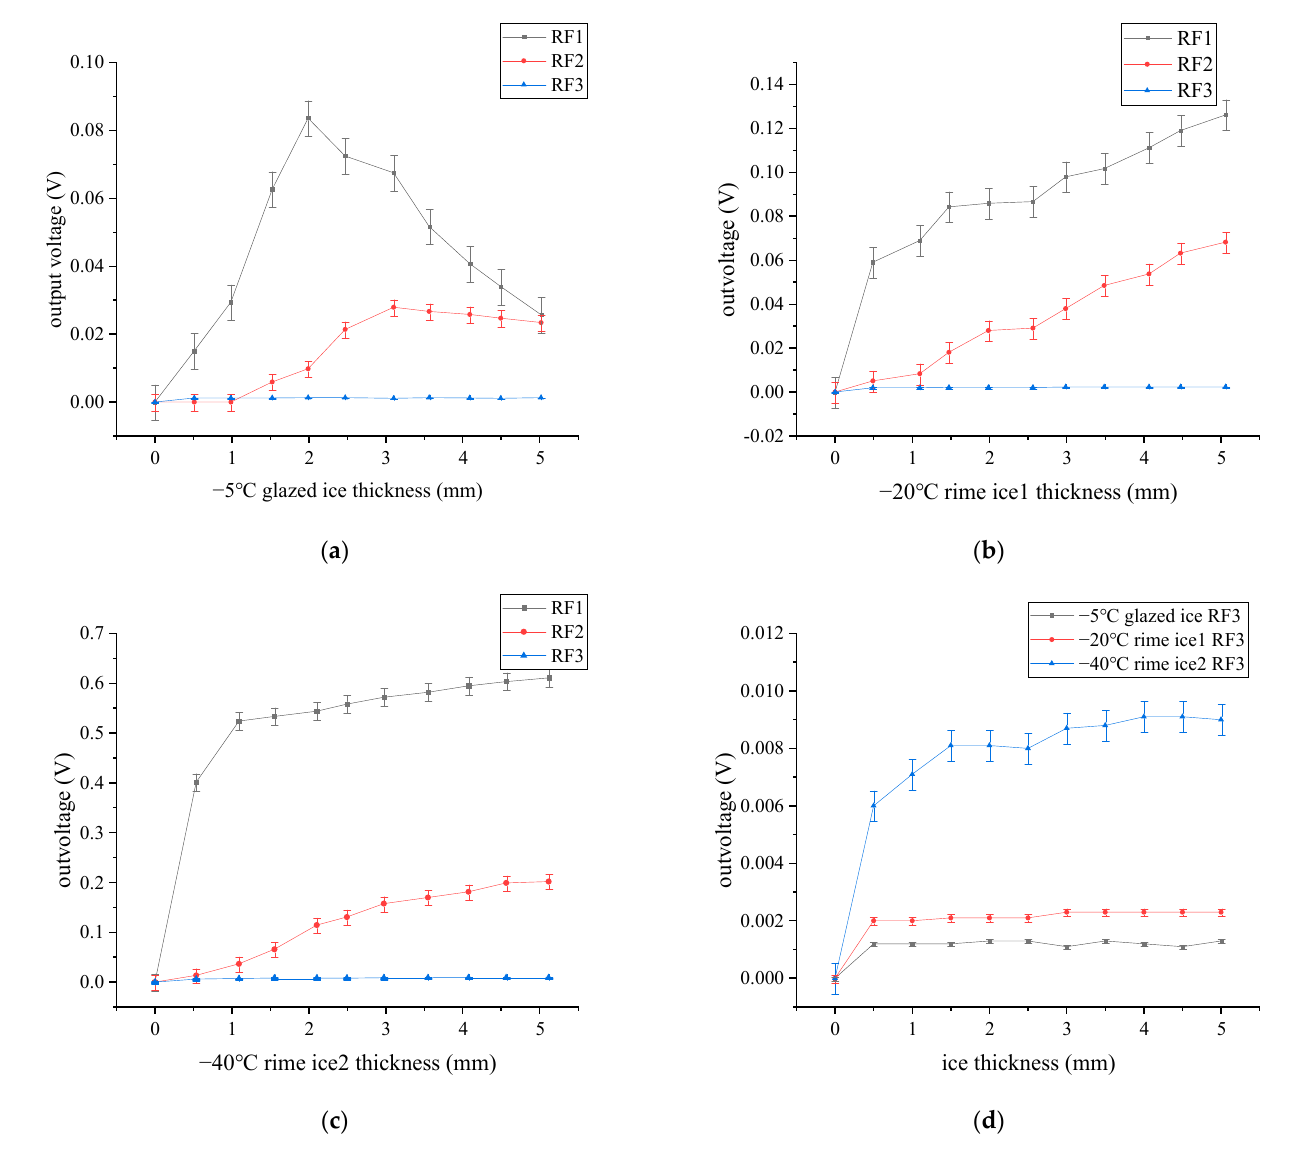
Figure 9. Experiment results: ( a ) glazed ice; ( b ) rime ice 1; ( c ) rime ice 2; ( d ) comparison of different ice types.